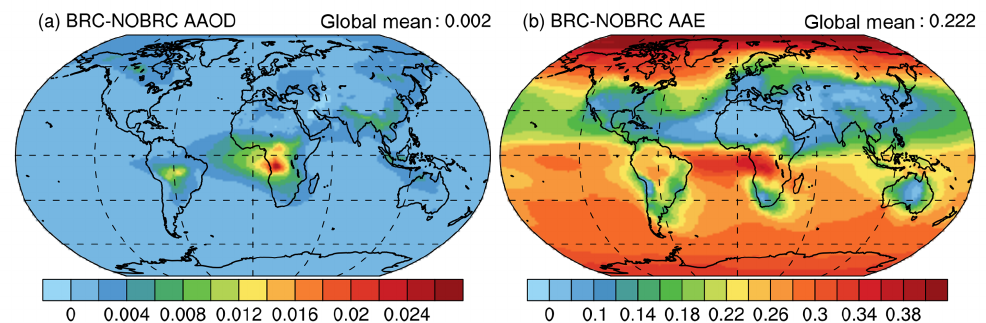
Figure 5. Differences in (a) AAOD and (b) the AAE between the BRC model run and the NOBRC model